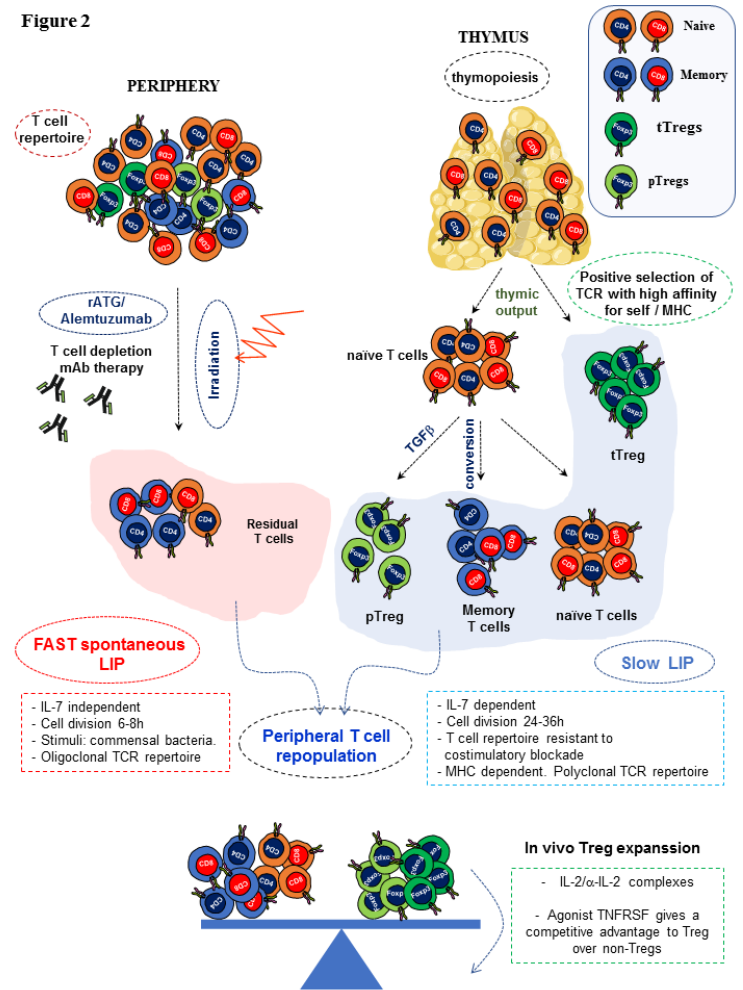
Figure 2. Hypothetical model of lymphopenia-induced homeostatic proliferation (LIP) in response to T cell depletion. Rabbit polyclonal anti-thymocyte globin ATG (rATG) and alemtuzumab are the two